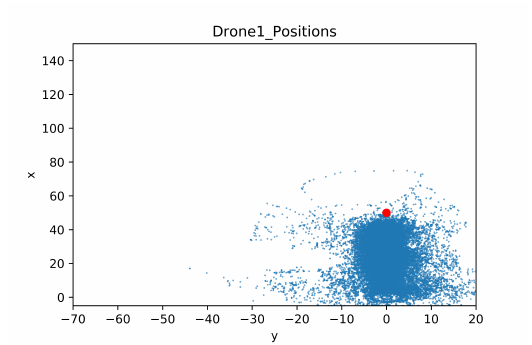
Figure 37. Drone Position Map for Case 2.2 by Transfer Learning.